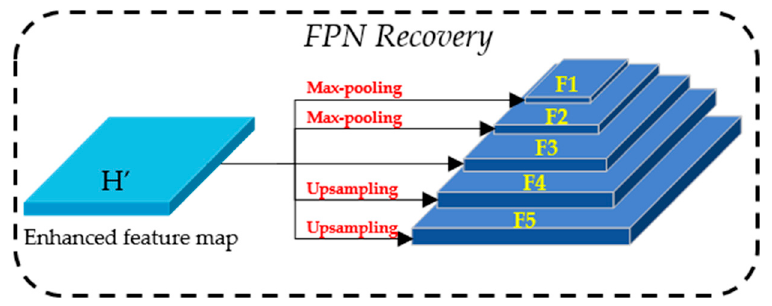
Figure 6. Architecture of feature pyramid recovery.